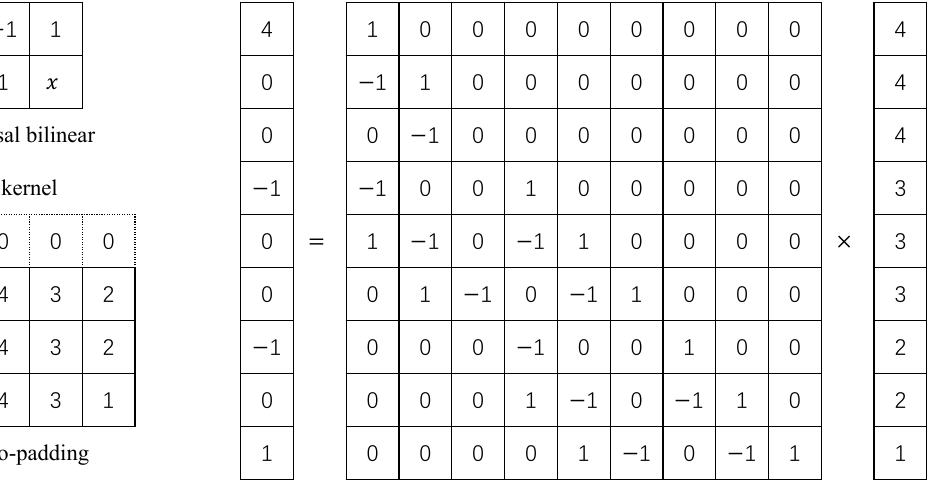
Figure A1. The encoding procedure of the prediction scheme. The column of an atom is arranged as a 3 × 3 matrix, and the elements outside of the range are assumed to be zero. The causal bilinear predictor is assumed to be a 2 × 2 template, and the mapping matrix W is of the size 9 ×